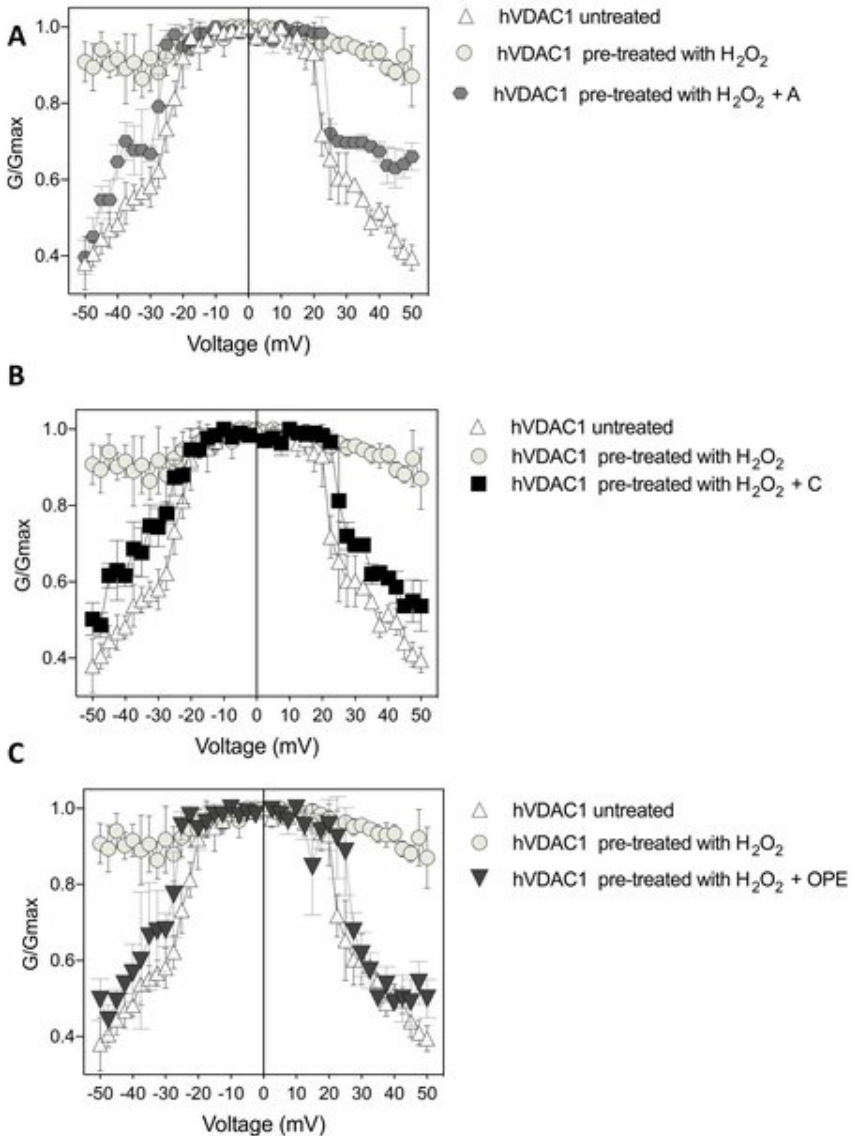
Figure 4. Conductance G/Gmax of hVDAC1 untreated ( A – C ), pre-treated with 8 µM H 2 O 2 ( A – C ) and challenged with sample A (panel ( A )), sample C (panel ( B )) and sample OPE (panel ( C )) as function of the applied voltage. Data are expressed as mean of at least 4 independent experiments.